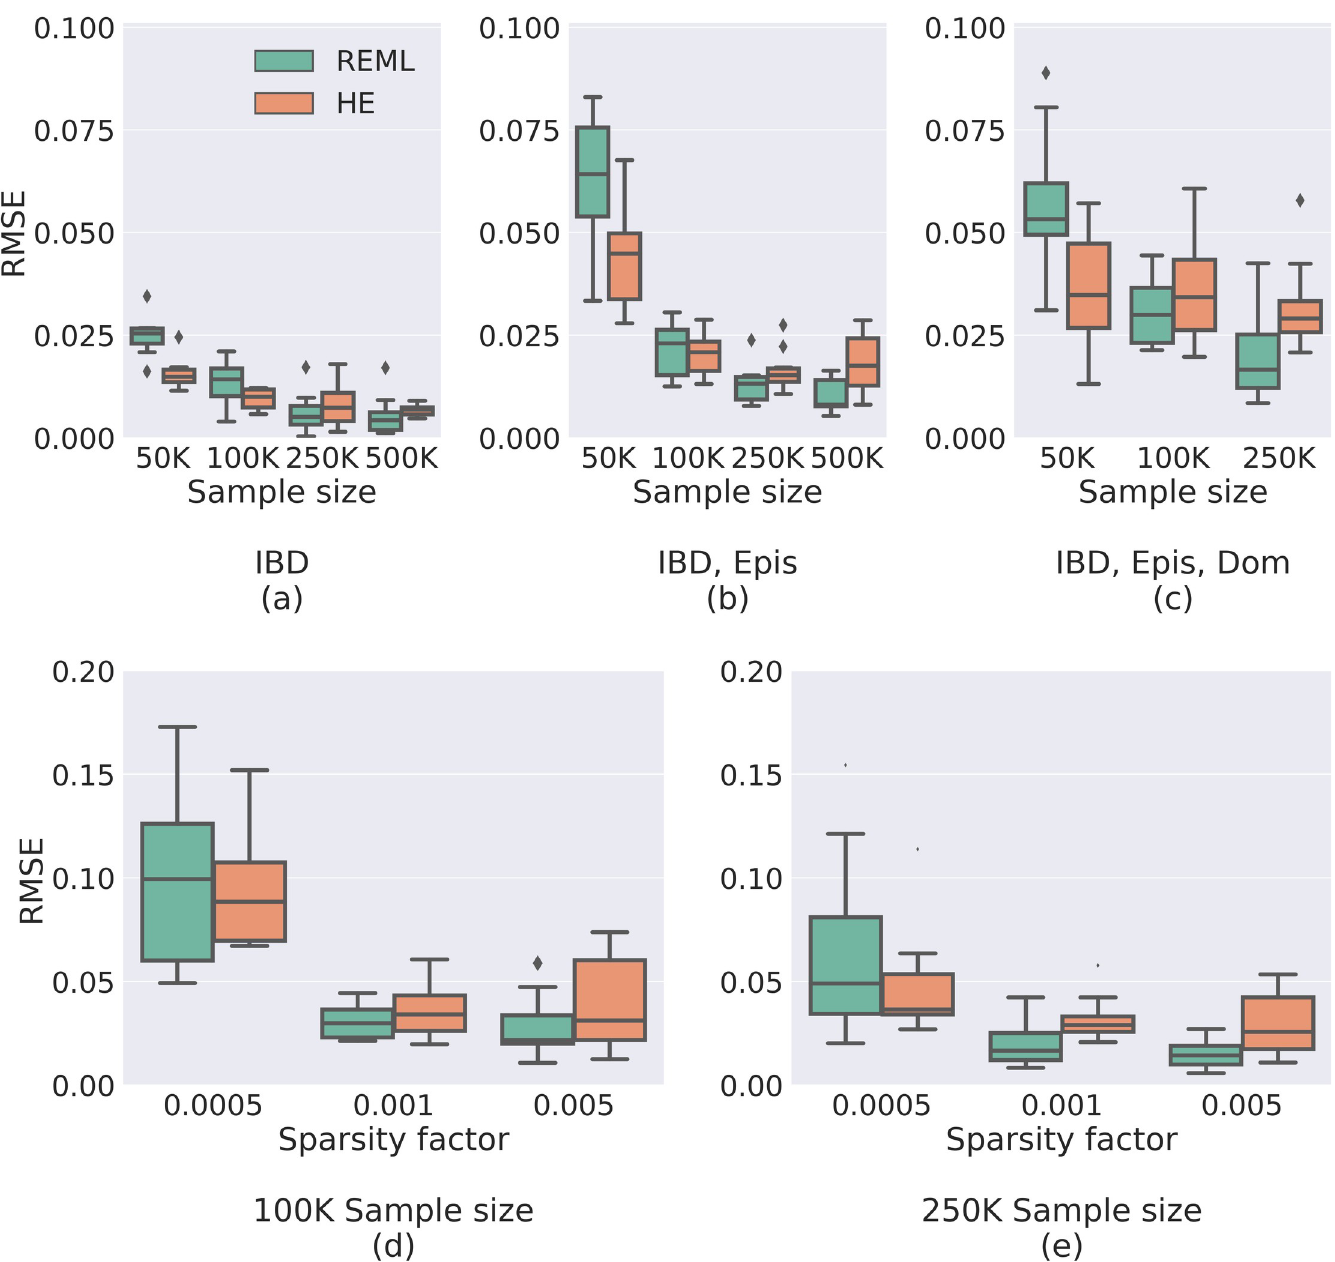
Fig 2. Evaluating the estimation accuracy of Sci-LMM. ( a-c ) Box plots comparing REML and HE estimation accuracy (RMSE) across simulated datasets (each box represents 10 experiments), under varying sample sizes, using (a) only IBD, (b) IBD and epistasis, or (c) IBD, epistasis and dominance variance components. HE is more accurate than REML for smaller sample sizes, but REML outperforms HE as the sample size increases. Results for analyses with three matrices and 500,000 individuals are omitted due to excessive required computational time. ( d-e ) Comparing REML and HE estimation accuracy when using IBD, epistasis and dominance matrices under various sparsity factors (the fraction of non-zero matrix entries) with either (d) 100,000 individuals, or ( e ) 250,000 individuals. The estimation accuracy of both REML and HE increases with the number of non-zero entries, for both REML and HE.